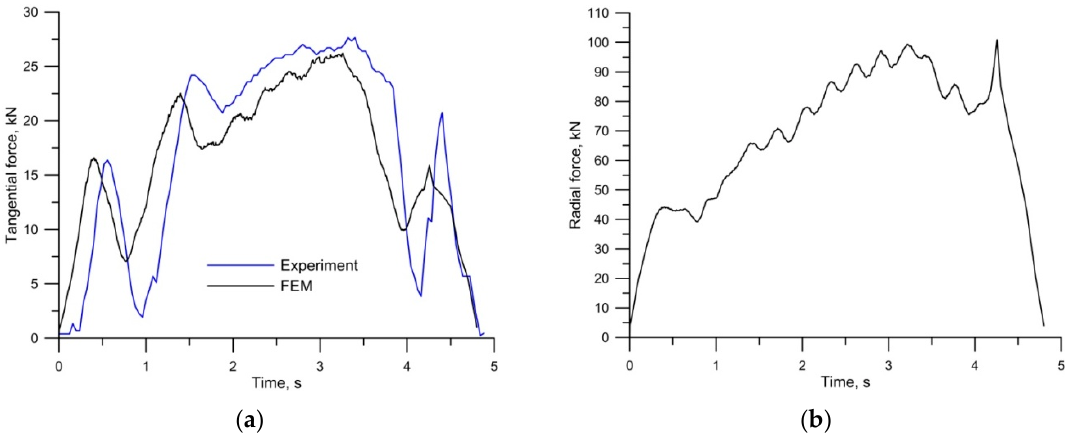
Force distribution parameter for cross-wedge rolling (CWR): ( a ) tangential force; ( b ) radial force.